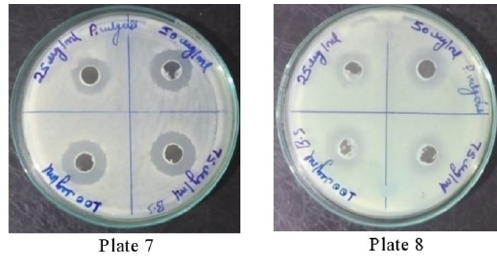
Fig. 6. Plate 5 &6 Anti-Bacterial Activity of Methanolic Extract of P. vulgaris against E. coli